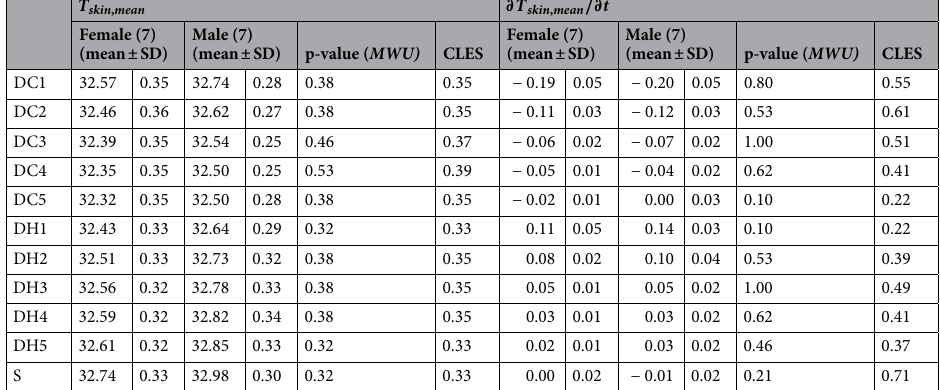
Table 7. Sex differences in mean skin temperature and its rate of change over the course of the last two partial-body cooling and warming transients.